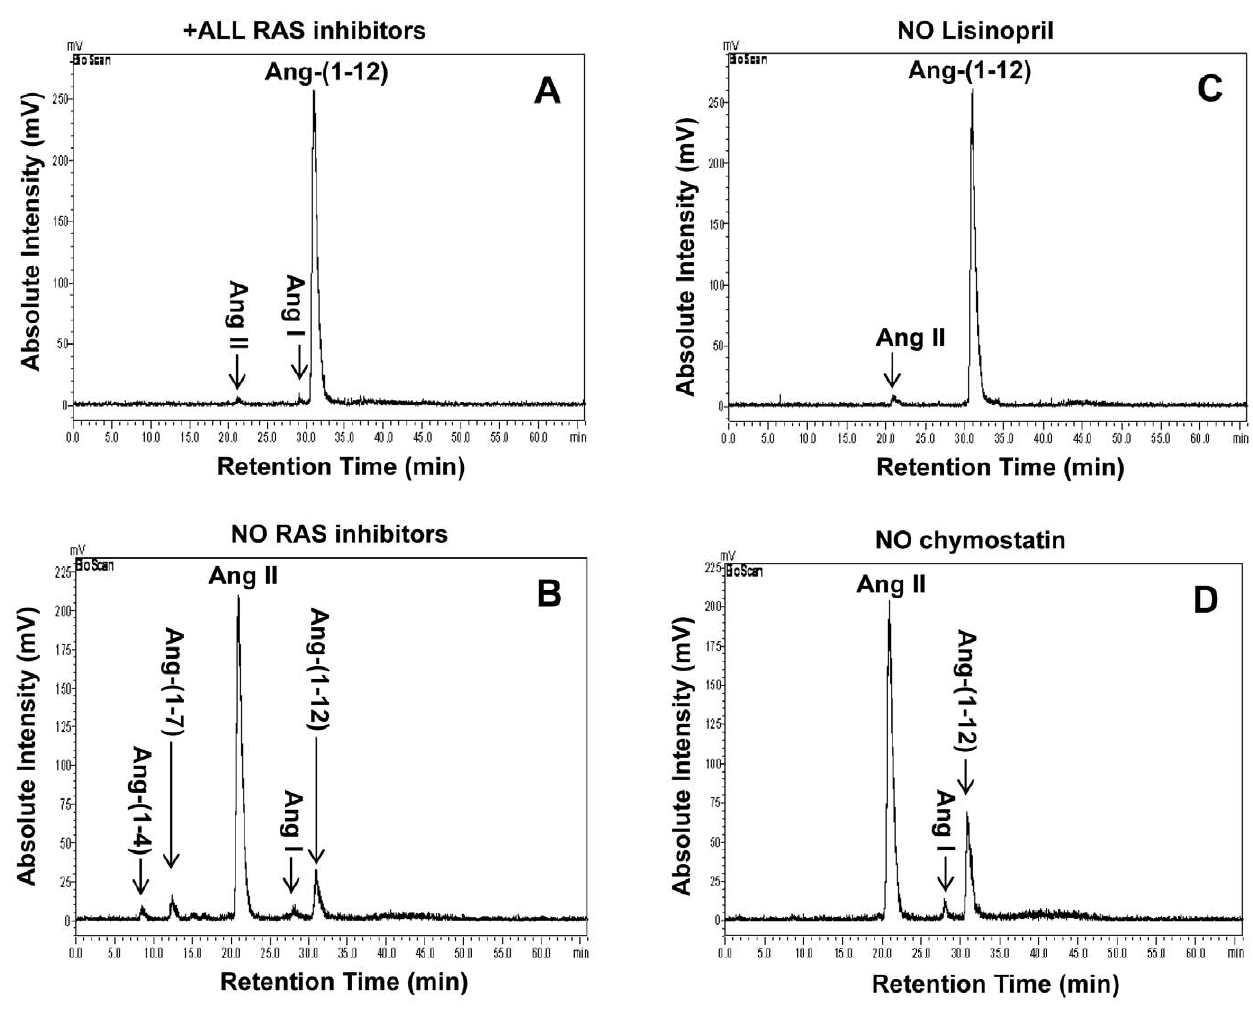
Figure 2. Ang-(1-12) metabolism by human atrial tissue. The metabolism of 125 I-Ang-(1-12) by plasma membrane isolated from human atrial tissues was analyzed by HPLC coupled to an inline BioScan c -detector. The 125 I-Ang-(1-12) was incubated with human plasma membrane for 60 min at 37 u C with or without the inhibitor cocktail and the metabolites were separated by HPLC. A : Chromatograms represent the hydrolysis of 125 I-Ang-(1- 12) in the presence of all RAS inhibitors ( All RAS inhibitor group containing lisinopril, SCH39370, MLN-4760, chymostatin, bestatin, amastatin, benzyl succinate, and PCMB). B : Hydrolysis of 125 I-Ang-(1-12) in the absence of all RAS inhibitors cocktail ( No RAS inhibitors group containing only bestatin, amastatin, benzyl succinate, and PCMB). C : Hydrolysis of 125 I-Ang-(1-12) in the presence of the inhibitor cocktail that lacks only Lisinopril ( No lisinopril inhibitor group containing all inhibitors as described in ‘‘ A ’’ except ACE inhibitor). D : Hydrolysis of 125 I-Ang-(1-12) in the presence of inhibitor cocktail that lacks only chymostatin ( No chymostatin group containing all inhibitors as described in ‘‘ A ’’ except chymase inhibitor). Before adding the 125 I-Ang- (1-12), the plasma membrane was pre-incubated with inhibitors (each added at a dose of 50 m M) for 15 min at 37 u C. The arrow indicates the retention time of 125 I-Ang-(1-12) and its metabolic products. HPLC results are representative of three or more separate metabolism experiments for each human sample.